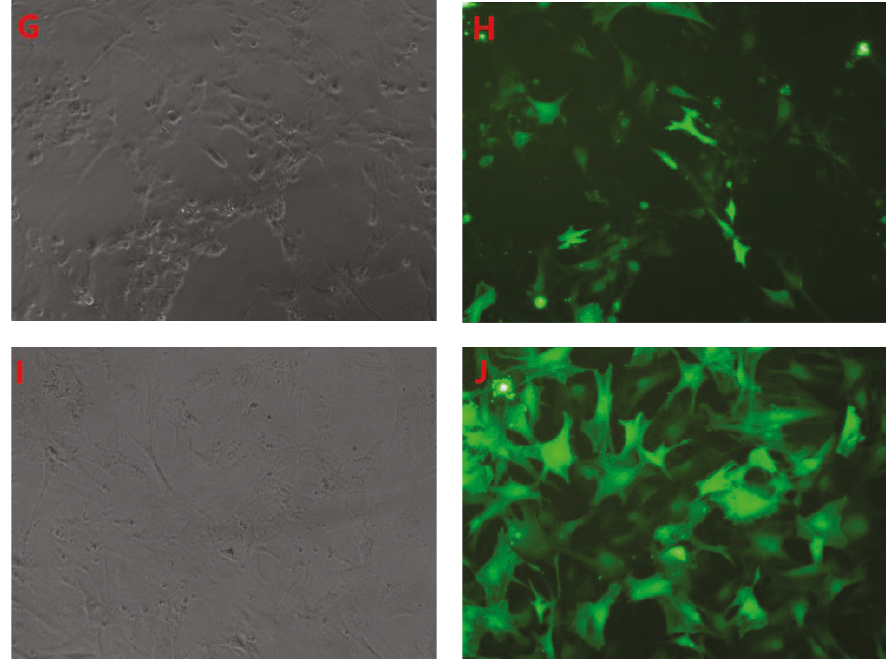
Figure6:ItshowedthattheautophagyinNPcellsincreasedwhentheagonistwasaddedtothehighglucosemedium,whileitdecreasedwhen the antagonist was added ((G, I) light microscope; (H, J) fluorescence microscope. (G) and (H) represent as 0.2 M high glucose + agonist; (I) and (J) as 0.2 M high glucose + antagonist, resp.).